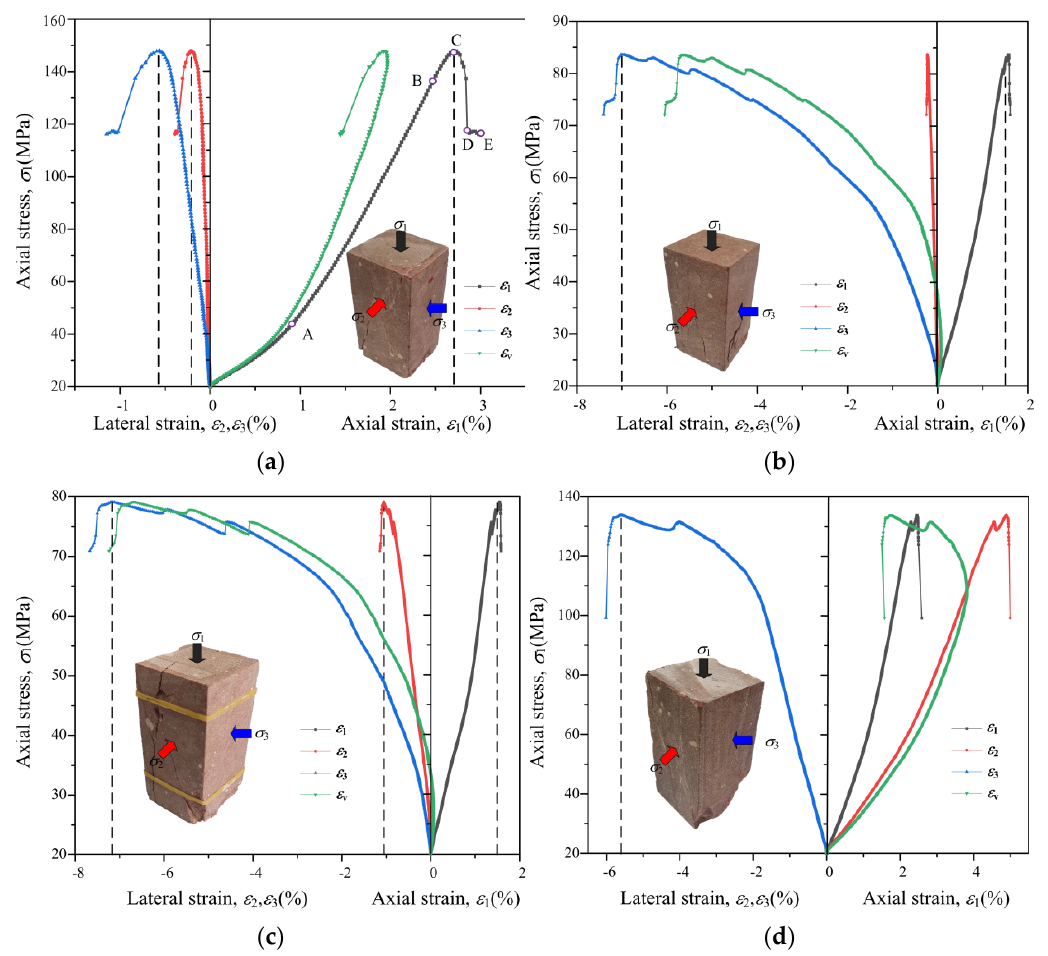
Figure 6. Complete stress–strain curves of red sandstone under true triaxial loading–unloading stress paths. ( a ) LCCT; ( b ) LCUT; ( c ) LUUT; ( d ) LLUT.